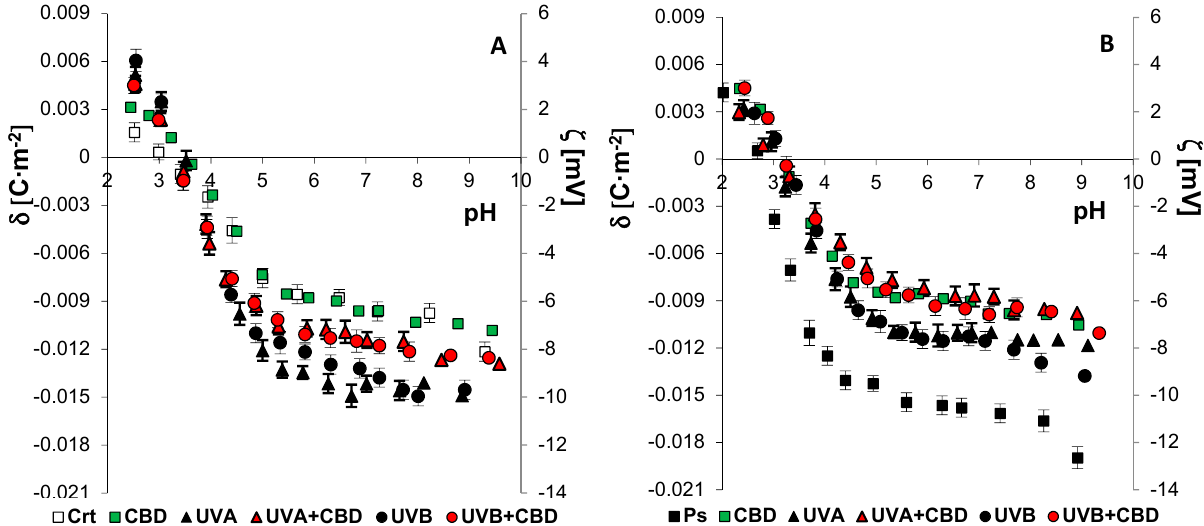
Figure 5. The surface charge density ( left axis ) and corresponding zeta potential ( right axis ) of fibroblasts isolated from skin of healthy subjects (Ctr) ( A ) ( n = 6) and psoriatic patients (Ps) ( B ) ( n = 6) exposed to UVA (30 J/cm 2 ) and UVB (60 mJ/cm 2 ) radiation as well as untreated and treated with CBD (4 µ M). The mean values ± SD are